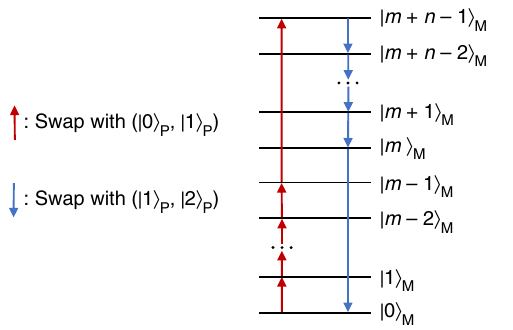
Fig. 2 The action of the cycle over the machine. The cycle S m , n is represented in a pictorial way over the eigenstates of the d -dimensional